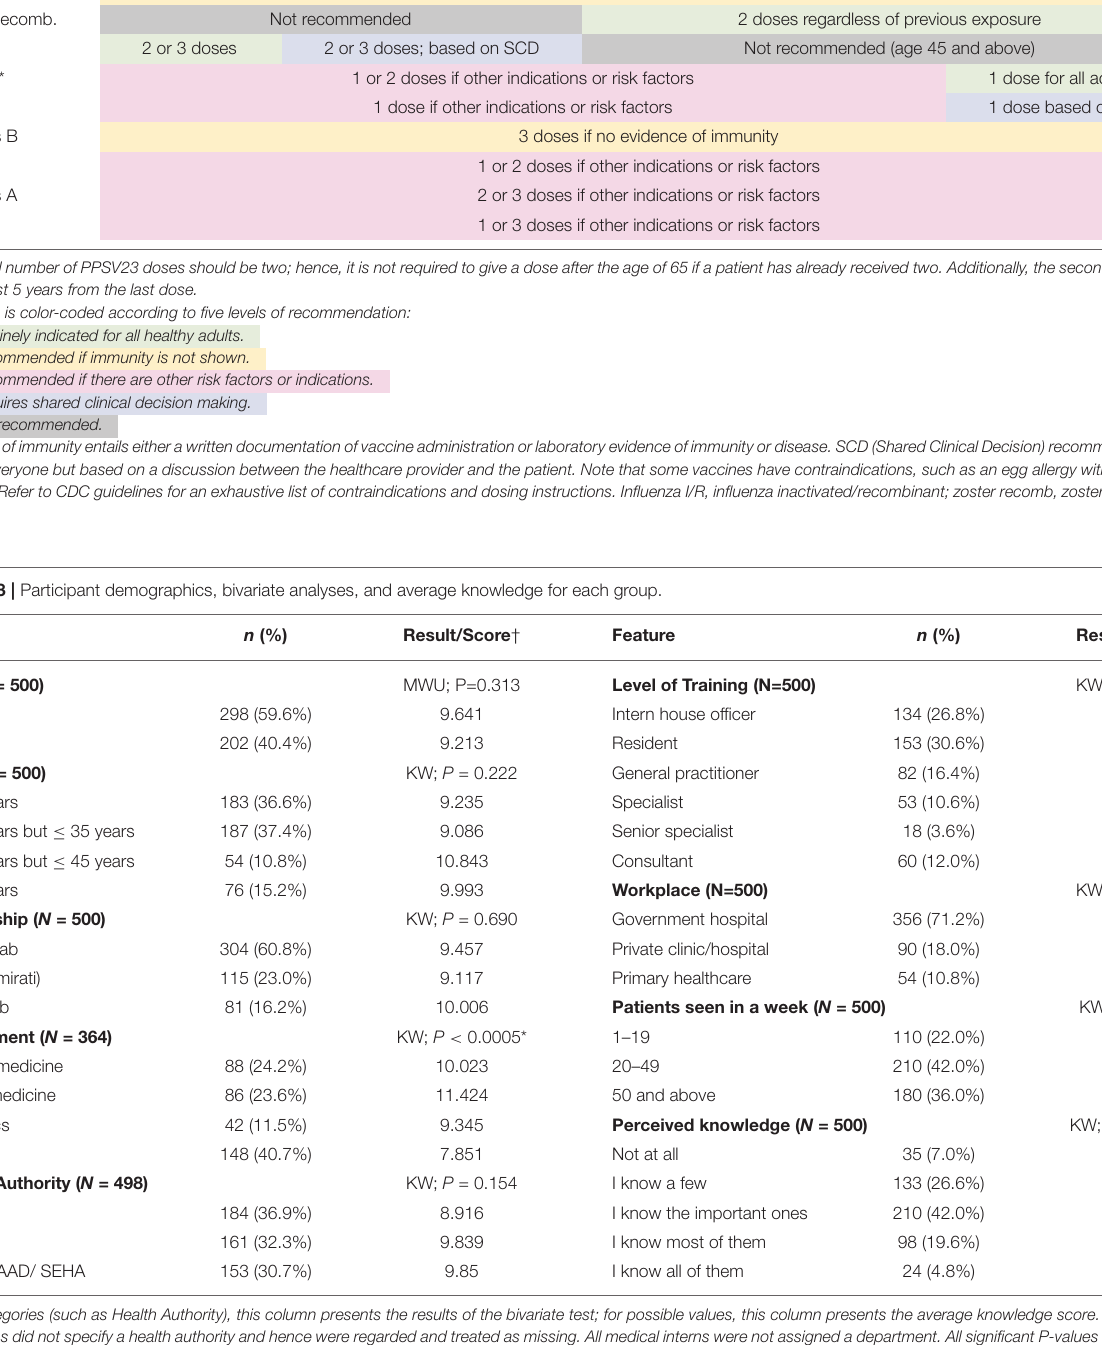
TABLE 2 | Recommended adult vaccination schedule.